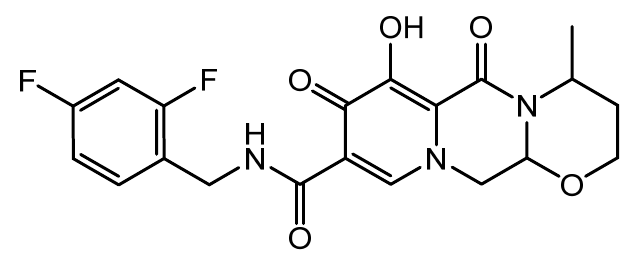
Figure 1. Chemical structure of